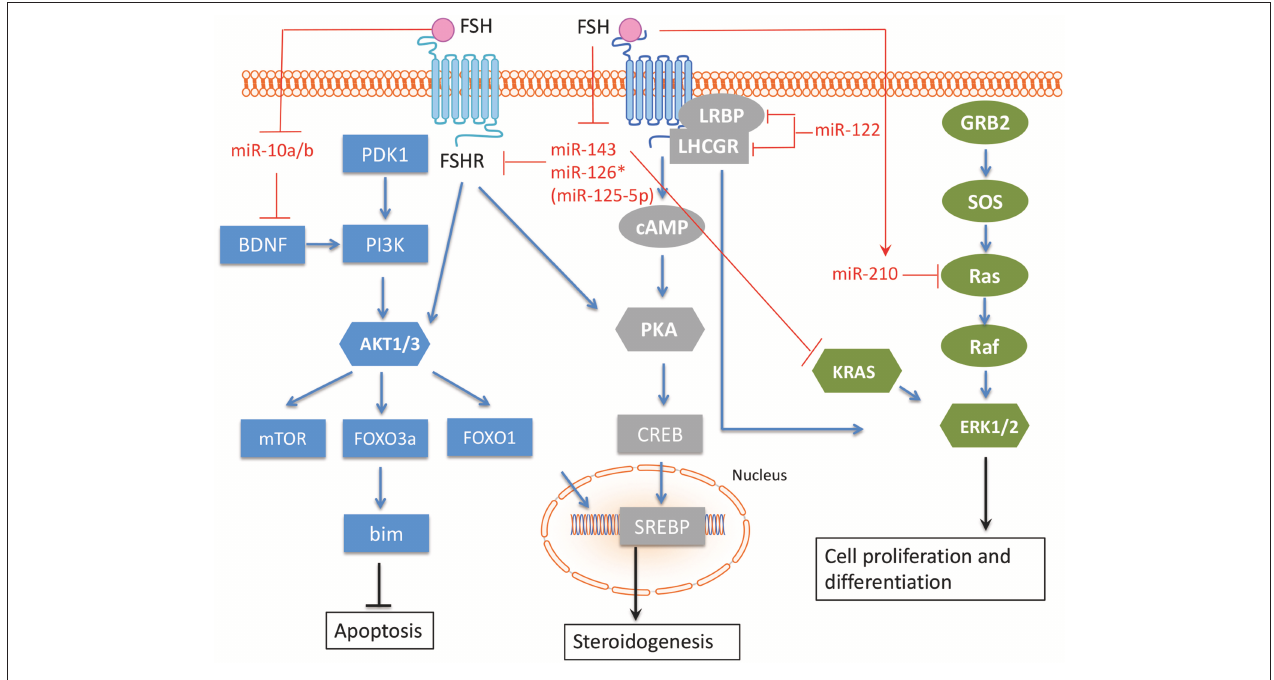
FIGURE 3 | The interaction between miRNAs and FSH pathway in GC. The related miRNAs regulate GC proliferation, angiogenesis, hormone secretion and differentiation via interacting with FSH pathway in GC. FSH, Follicle-stimulating hormone; FSHR, Follicle-stimulating hormone receptor; BDNF, Brain-derived neurotrophic factor; KRAS, V-Ki-Ras2 Kirsten Rat Sarcoma 2 Viral Oncogene Homolog; Ras, rat sarcoma viral oncogene homolog; LHCGR, luteinizing hormone/chorionic gonadotropin receptor; LRBP, luteinizing hormone receptor mRNA-binding protein. Arrowhead line, promotion; Flat-end line, repression.